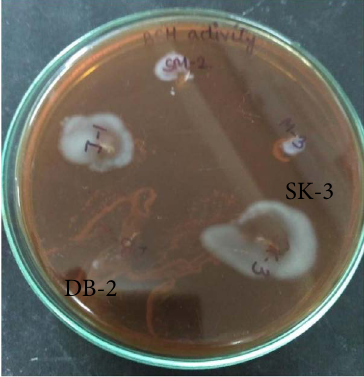
Fig. 9. Plate showing BSH activity of L. plantarum SK-3 All the probiotic attributes tested in this study revealed the safe status of both the isolates for further use in the food and fermentation industry. However, further evaluation of their beneficial effects on human beings will promote the application of both the strains in the pharmaceutical and cosmetic